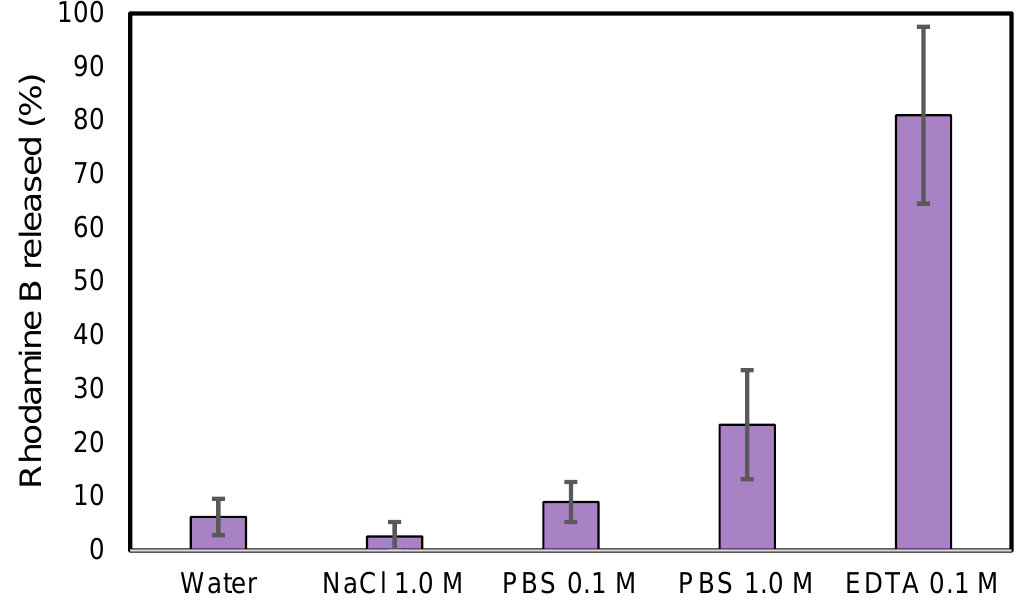
Figure 6. Stability of ZIF-8@RB in different mediums.